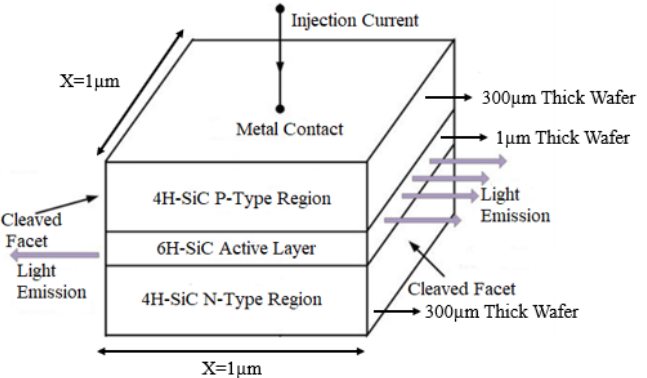
Figure 3. Schematic of 4H-SiC/6H-SiC/4H-SiC single quantum-well double hetero-structure edge- emitting LED.